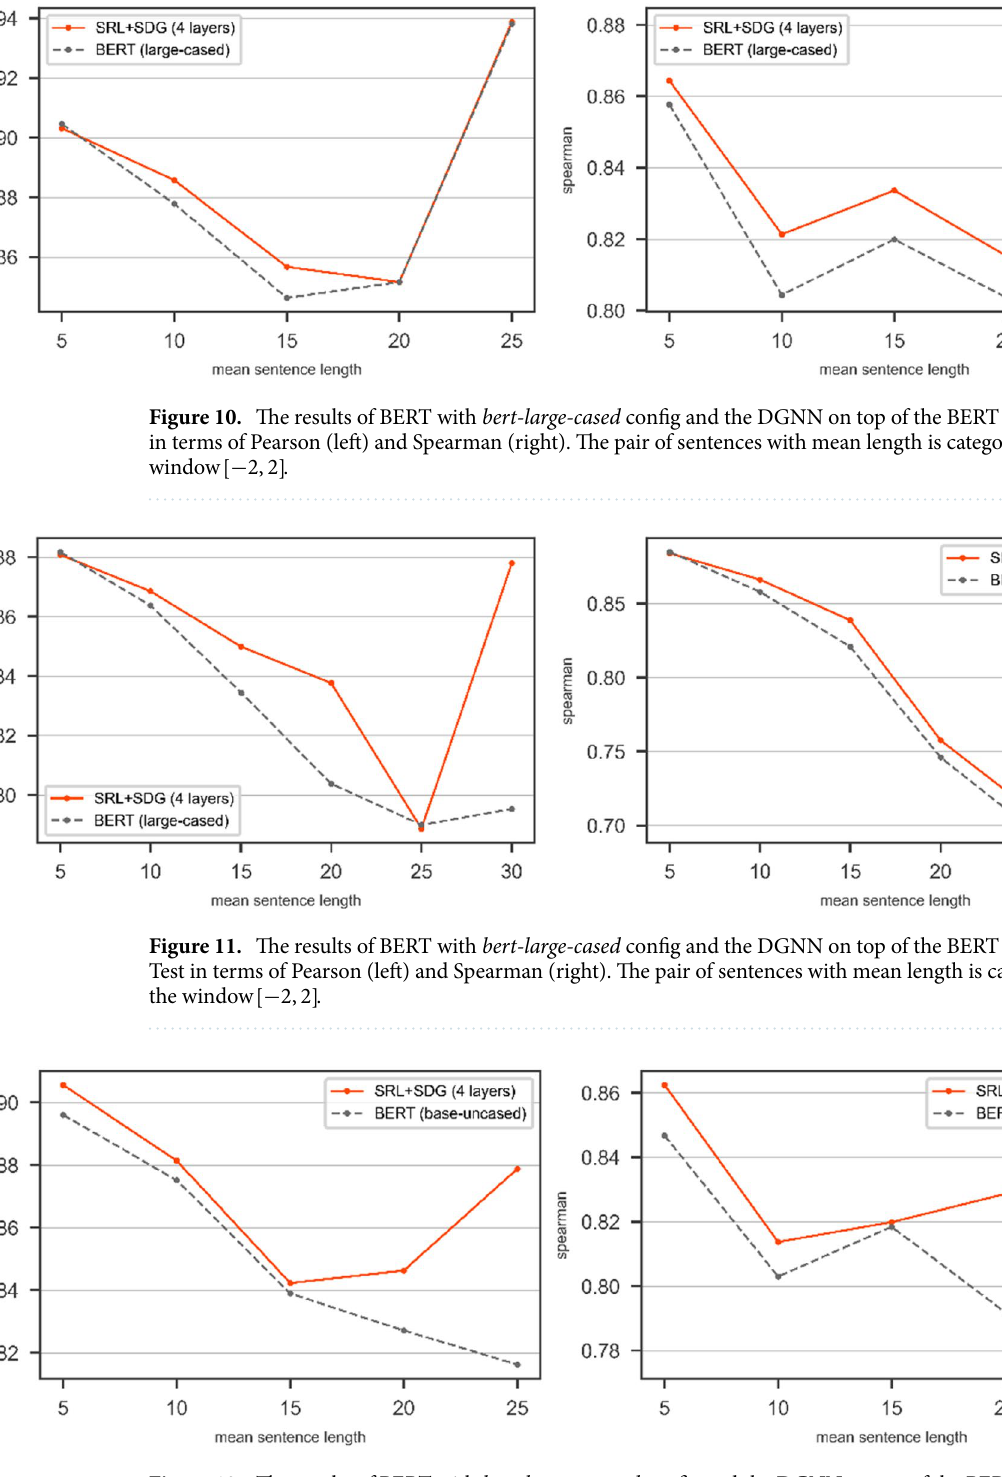
Figure 12. The results of BERT with bert‑base‑uncased config and the DGNN on top of the BERT on SICK/Test in terms of Pearson (left) and Spearman (right). The pair of sentences with mean length is categorized in the window [ − 2, 2]